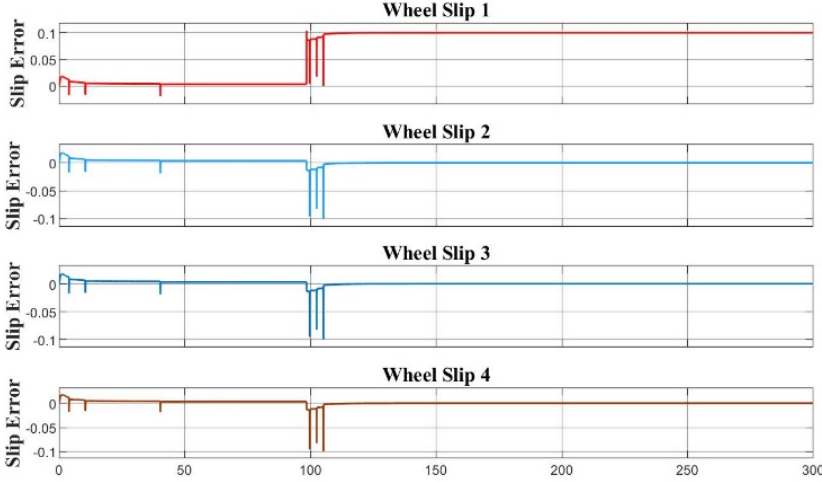
Figure 11. Tire slip error after fault injection in Wheel 1.